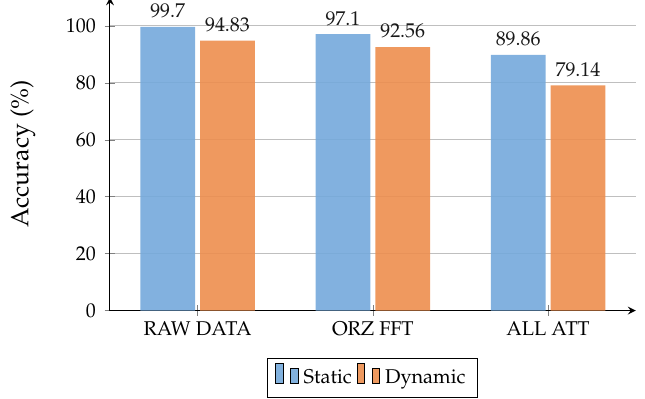
Figure 7. Comparison of best supervised models in static and dynamic